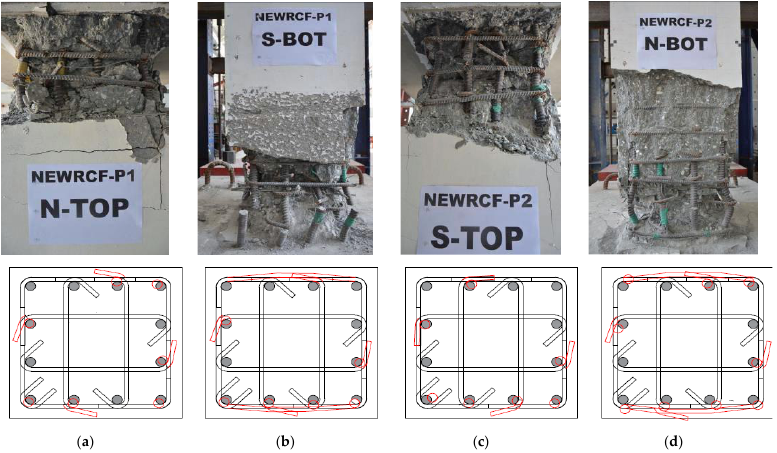
Figure 7. Crack pattern at damage at the end of the test NEWRCF: ( a ) P1-Top; ( b ) P1-Bot; ( c ) P2-Top; ( d ) P2-Bot.